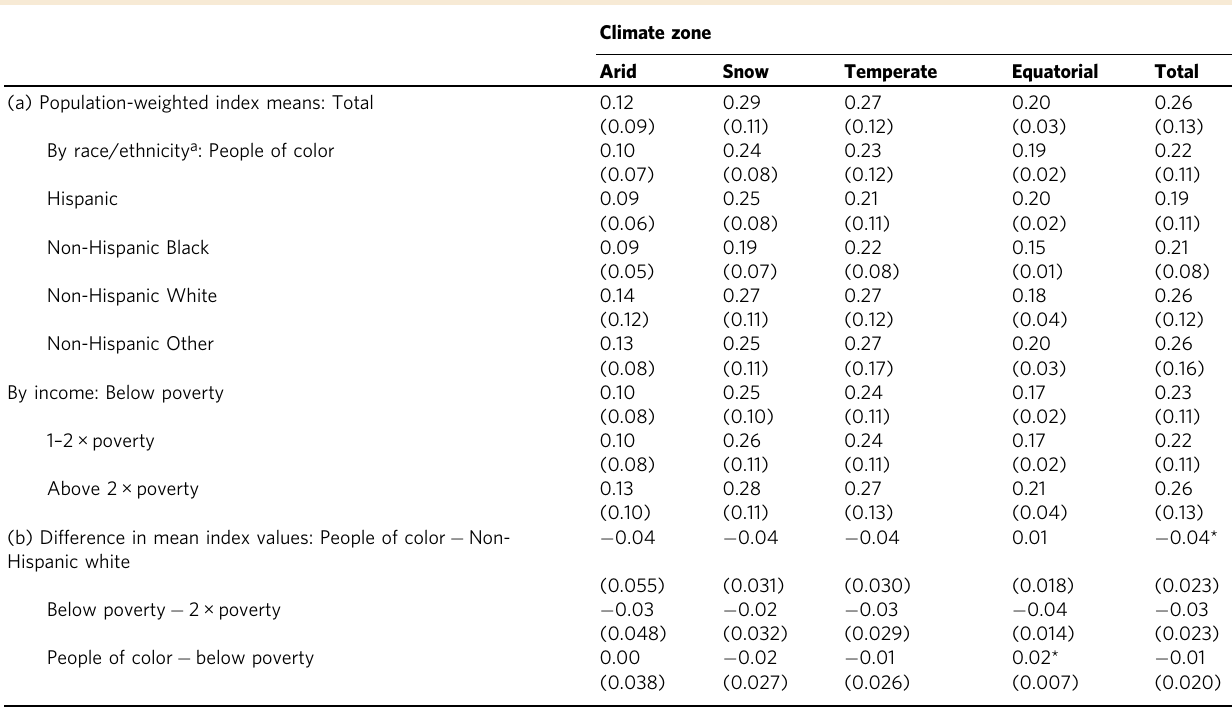
Table 2 Kolm – Pollak inequality index of summer daytime surface urban heat island intensity (SUHI) by climate zone and sociodemographic